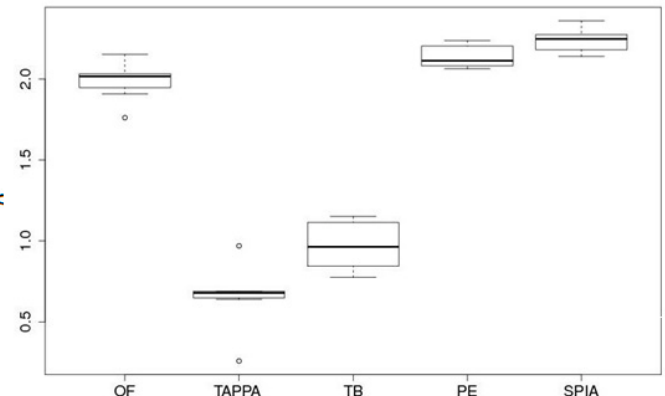
Figure 1. Data aggregation effect R for five pathway activation scoring methods (OncoFinder (OF), TAPPA, TBScore (TB), Pathway-Express (PE) and signaling pathway impact analysis (SPIA)) on a renal carcinoma dataset [30] .